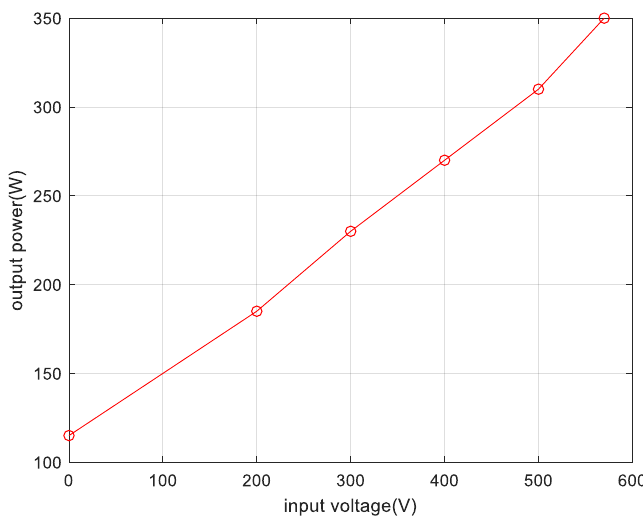
Figure 8. The output power and the input voltage.